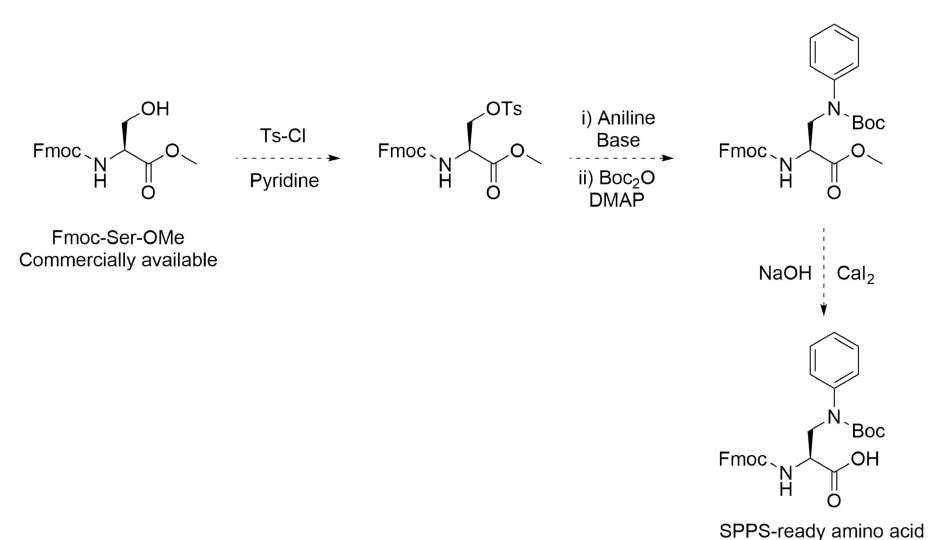
Figure S3: Observed products of Fmoc-Gly-OMe saponification after 4 hours at RT using 1 to 4 equivalents of Ca(OH) 2 and (A) 4 equivalents of CaCl 2 (B) 9 equivalents of CaCl 2 (C) 19 equivalents of CaCl 2 . Figure S4: Observed products of Fmoc-Gly-OMe saponification in a time course using (A) 1.5 equivalents of Me 3 SnOH (B) 10 equivalents of Me 3 SnOH. Figure S5: Chiral HPLC spectra